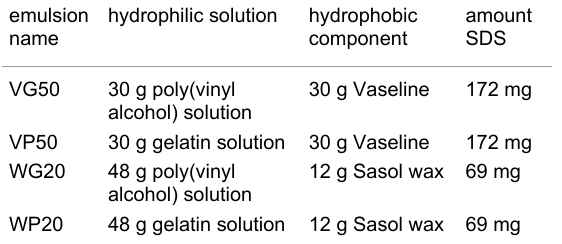
Table 2: Composition of first generation